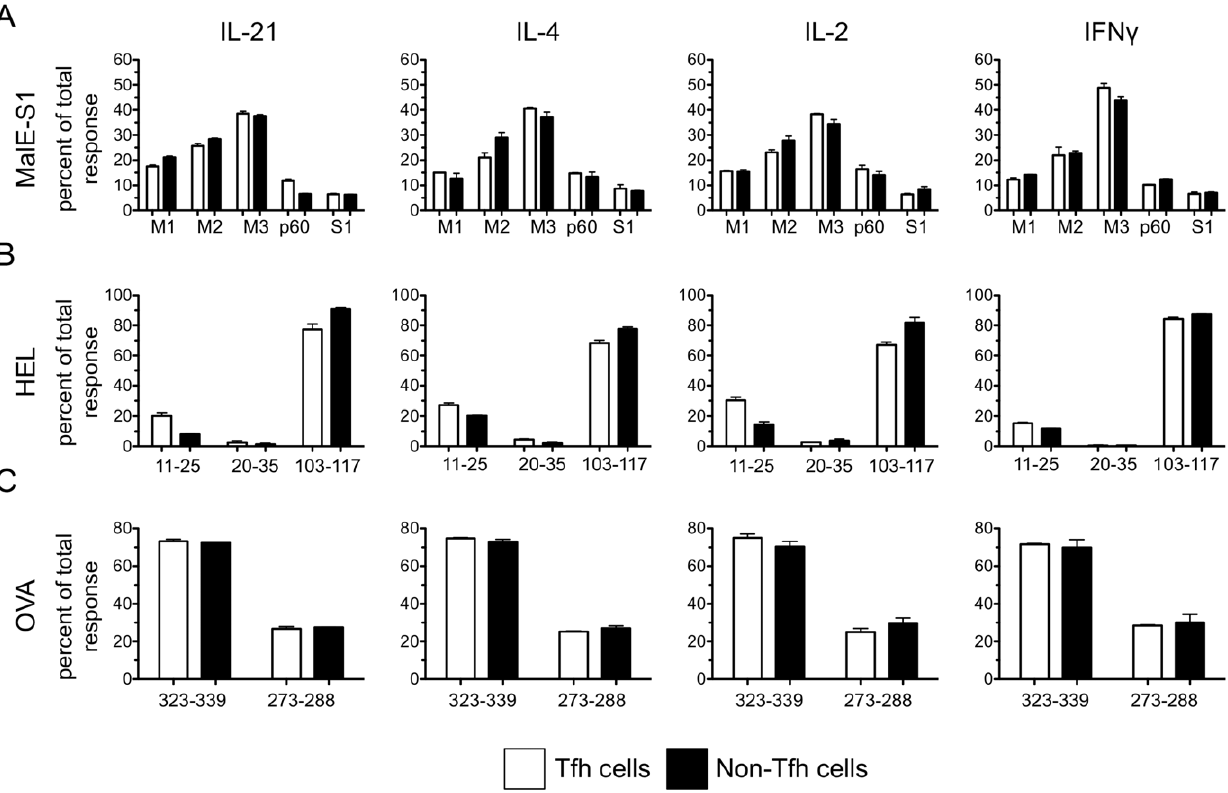
Figure 6. The peptide-specific hierarchies of the Tfh and non-Tfh population are remarkably similar, Independent of the cytokine assayed. The peptide specificities of Tfh and non-Tfh cells were evaluated with IL-2, IL-21, IL-4, and IFN c ELISPOT assays on day 8 or 9 post- immunization. The percent of the total response for each peptide tested (peptide-specific/sum of all peptide responses measured) generated after immunization with MalE encoding the S1 epitope (A), HEL (B), or OVA (C) are shown for both Tfh (open bars) and non-Tfh (shaded bars). Data are presented as the mean of two experiments with error bars representing the range.